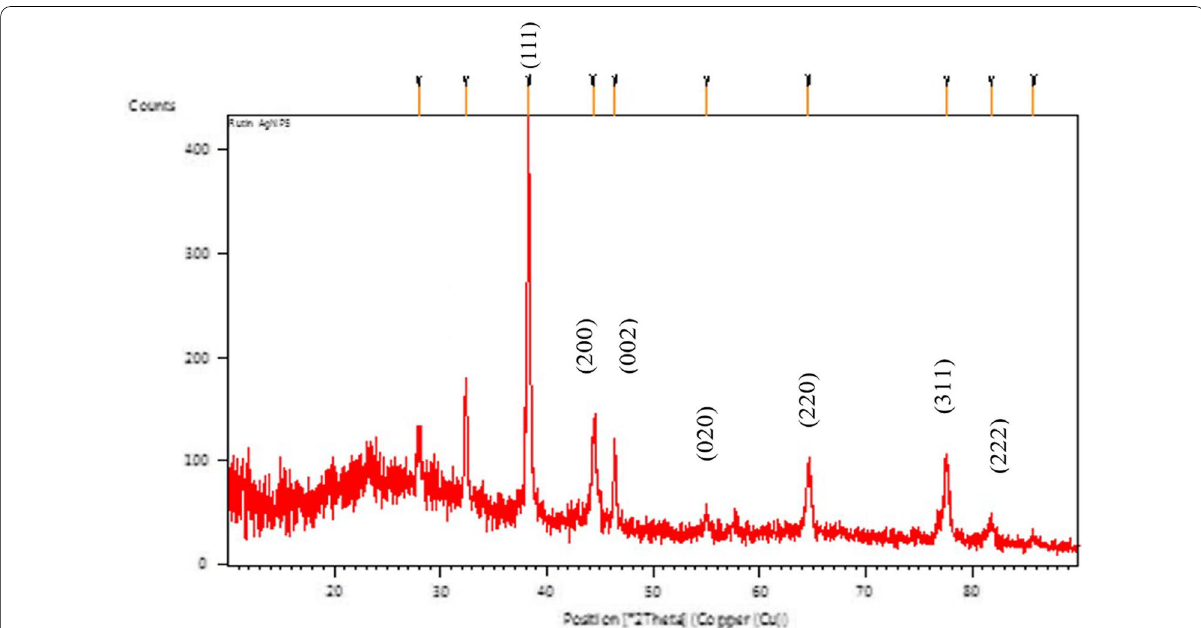
Fig. 4 XRD pattern of